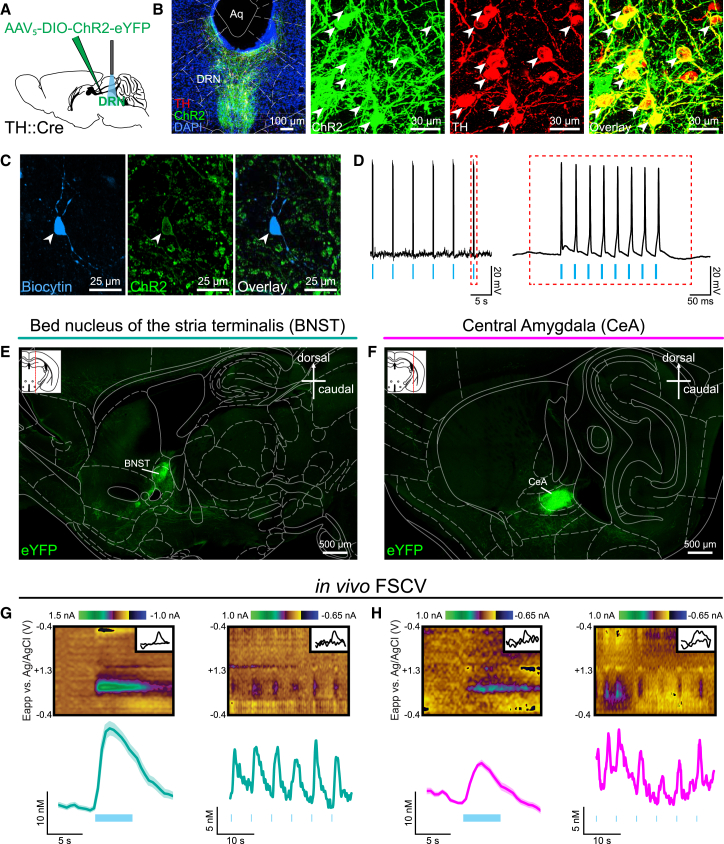
Photostimulation of DRN DA Neurons Elicits DA Release in the BNST and CeA(A) AAV5-DIO-ChR2-eYFP was injected into the DRN of TH::Cre mice to facilitate (B) ChR2 (green) expression in TH+ (red) DRN neurons. White arrows indicate selected co-labeled neurons.(C) Example of a biocytin-filled, ChR2-expressing, DRN neuron recorded using ex vivo electrophysiology.(D) ChR2 was activated using eight 5 ms pulses of blue light delivered every 5 s, which elicited a train of action potentials in the ChR2-expressing neuron.(E) Sagittal brain sections showing dense terminal expression in the BNST and (F) CeA following AAV5-DIO-eYFP injection into the DRN of a TH::Cre mouse.(G) In vivo FSCV was performed in anesthetized TH::Cre mice following Cre-dependent expression of ChR2 in the DRN. Example color plots and average traces (± SEM) from the BNST (n = 5 mice; 7 recording sites) and (H) CeA (n = 4 mice; 5 recording sites) showing DA release evoked by 150 5 ms pulses of blue light delivered at 30 Hz (left panels) and a representative trace showing eight 5 ms pulses delivered every 5 s (right panels). Eapp, applied potential. Insets show cyclic voltammograms from representative color plots.See also Figures S2 and S3.